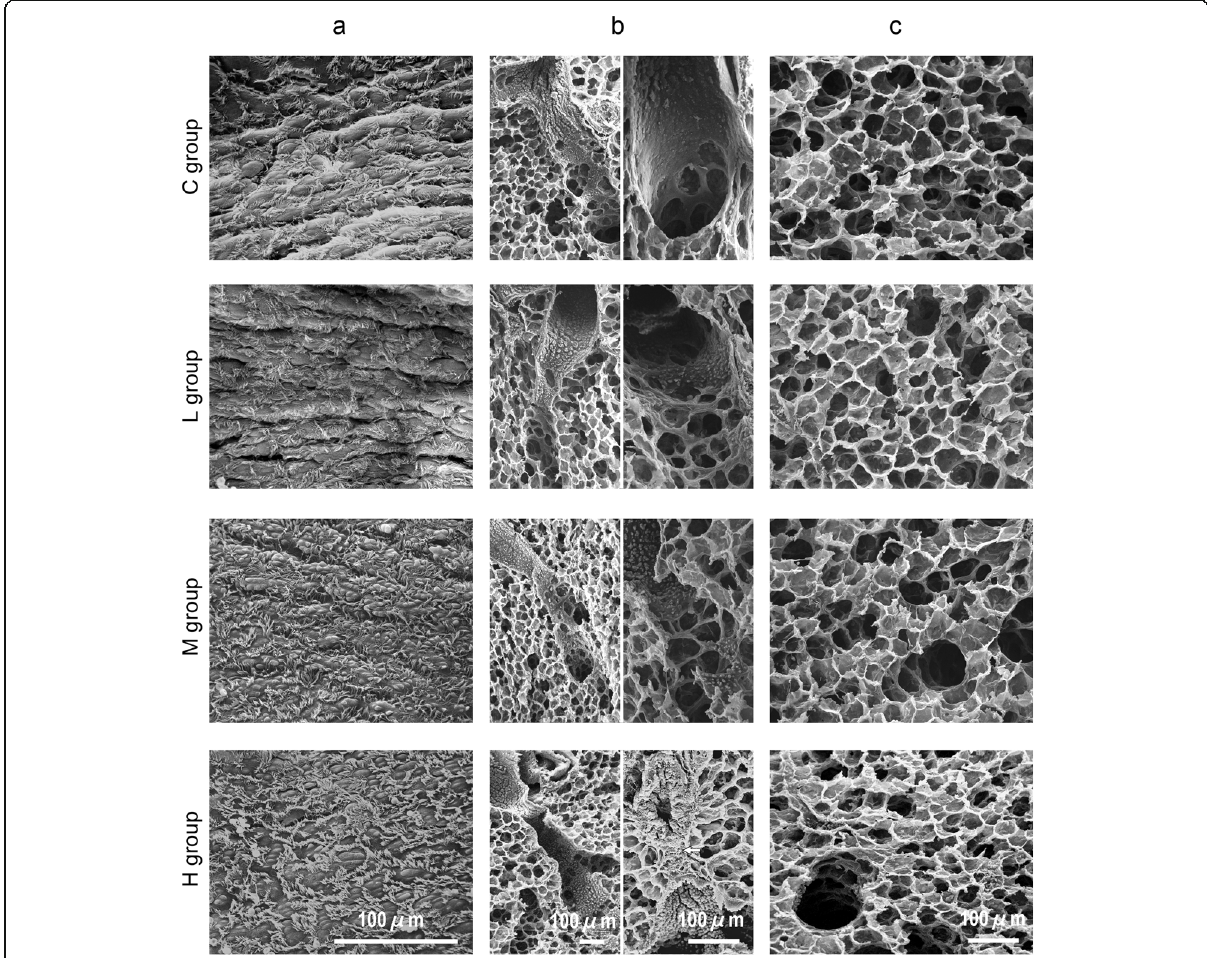
Fig. 4 Effect of HONO exposure on the respiratory tracts, observed under scanning electron microscope. a The bronchial lumen near the main bronchus. b The alveolar duct regions. c The alveolar